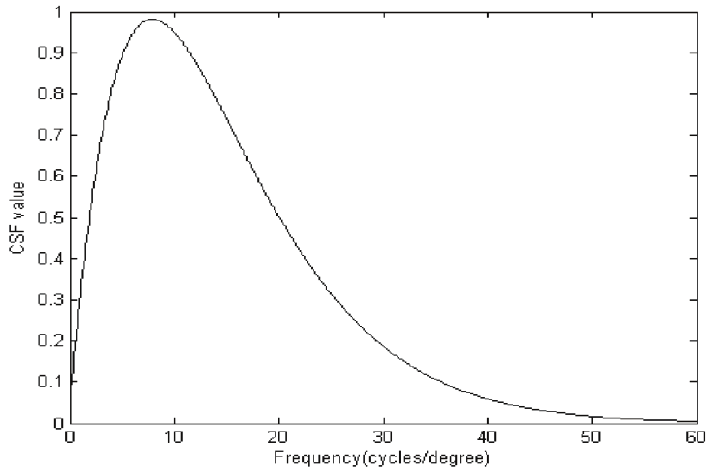
Figure 1. The spatial Contrast Sensitivity Function (CSF) curve with the spatial frequency (cycles/degree)